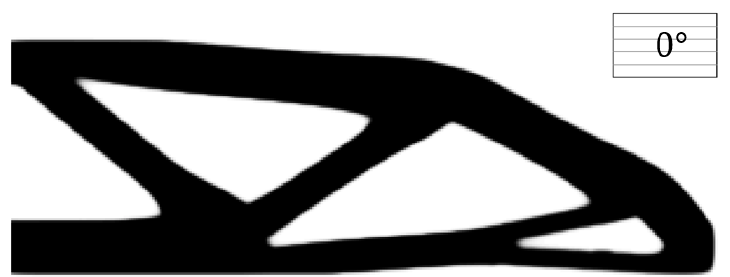
Figure 9. The optimized MBB beam without the boundary layer under the raster direction 𝜃 = 0° ( 𝑐 = 100.6204 ).